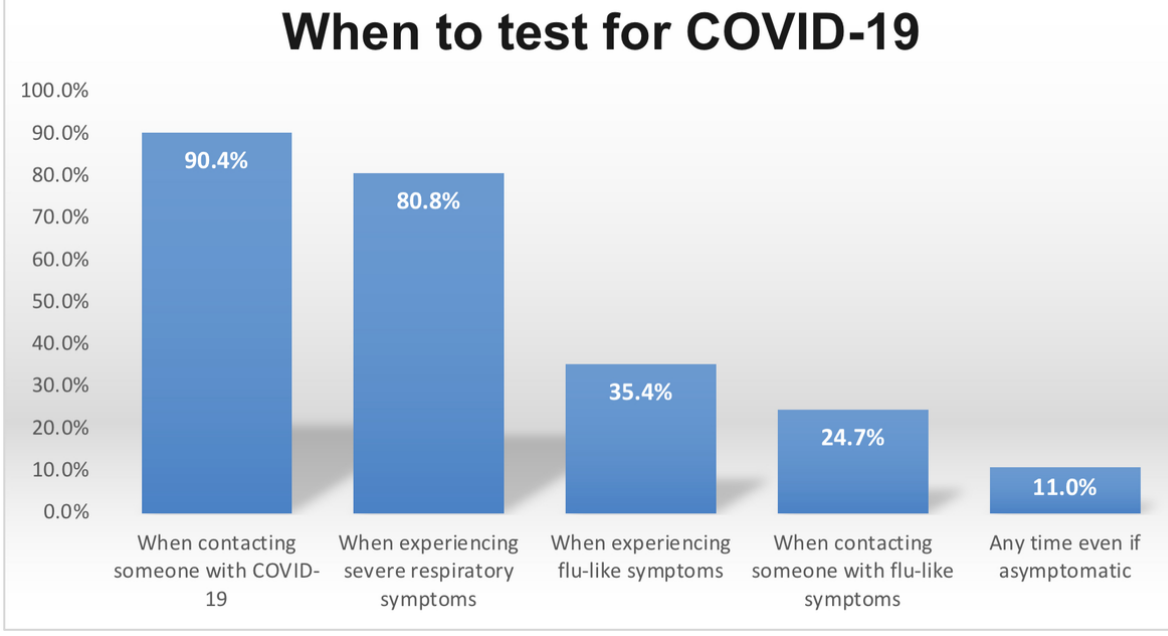
regards to wearing face masks in public places, 264 (46.9%) health care workers were always compliant, and 116 (20.6%) were not compliant. Furthermore, 290 (51.5%) health care workers frequently followed up with COVID-19–related news.